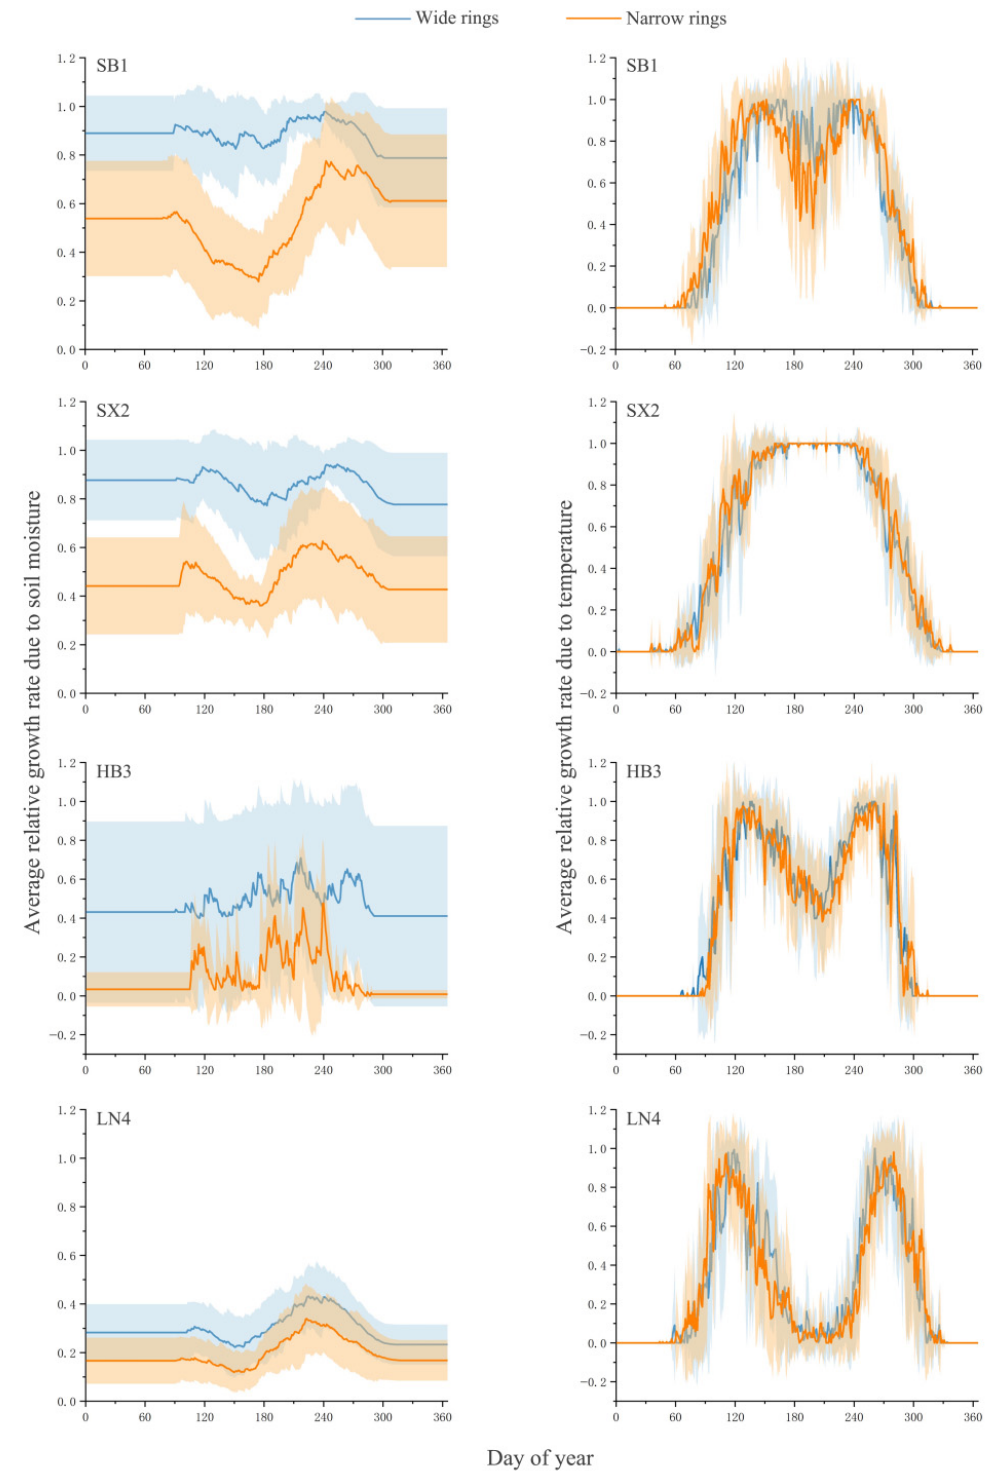
Figure 5. Comparison of the average growth rate in extremely wide and narrow rings years, as determined by temperature and soil moisture.